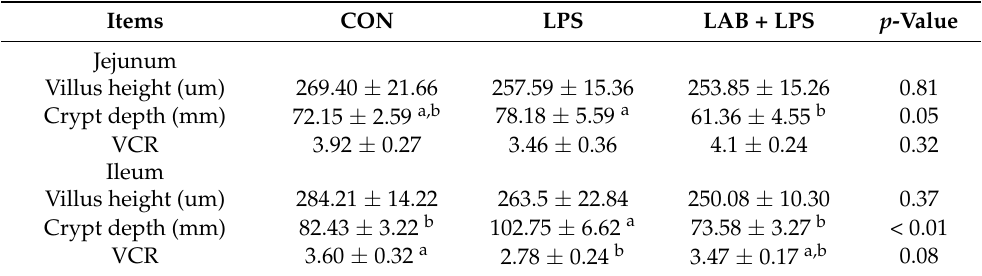
Table 3. The effects of LAB supplementation on the intestinal morphology of weaned piglets.